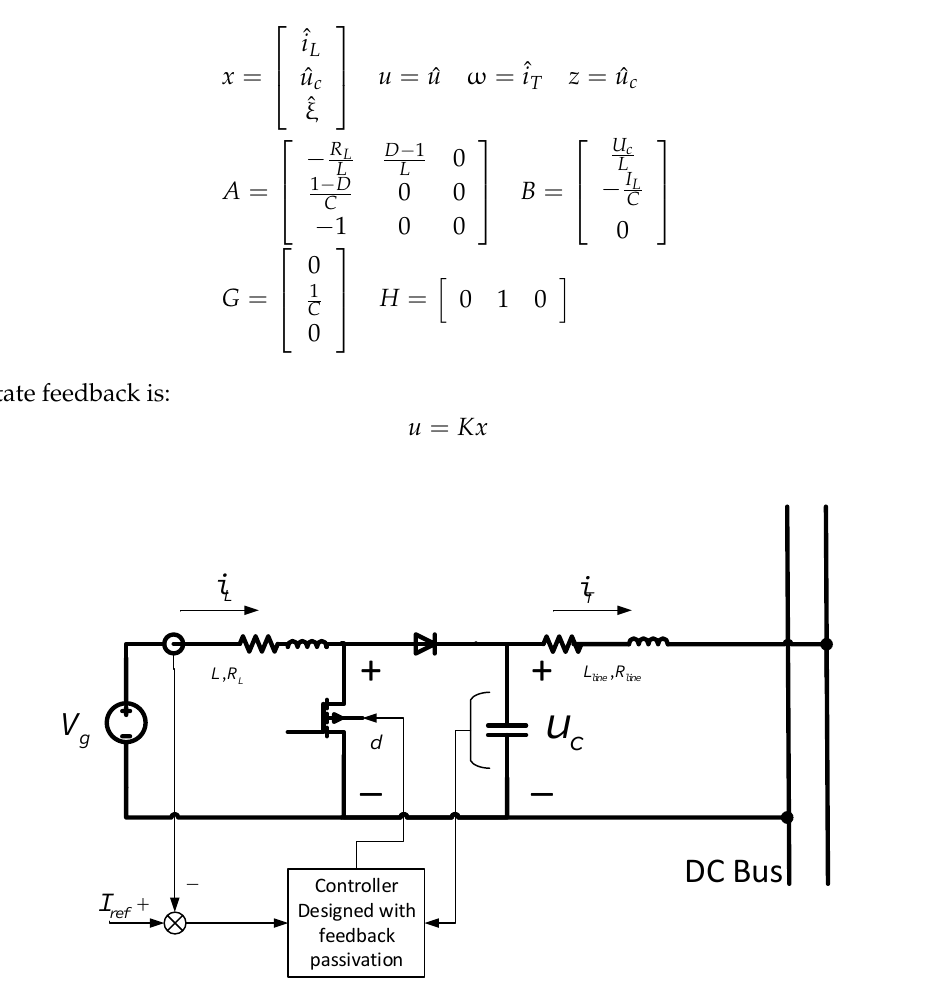
Figure 6. A grid-connected boost converter, operating in the current source